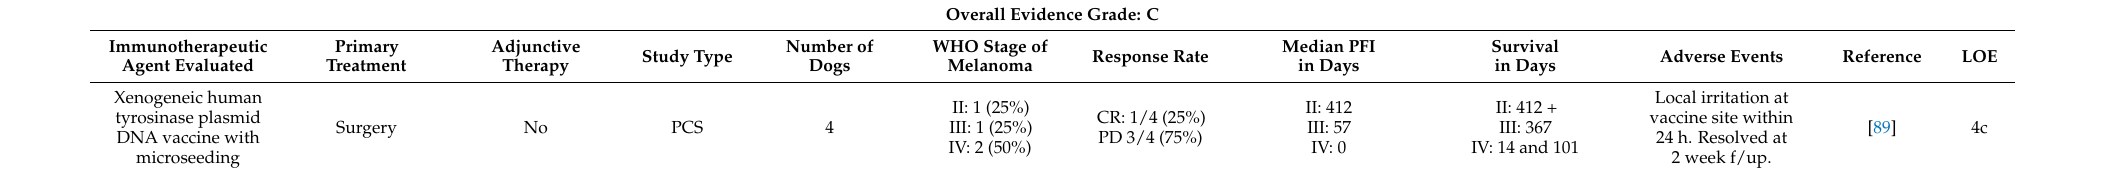
Table 10. Summary of vaccine microseeding studies evaluating effectivity in oral malignant melanoma. Overall Evidence Grade: C